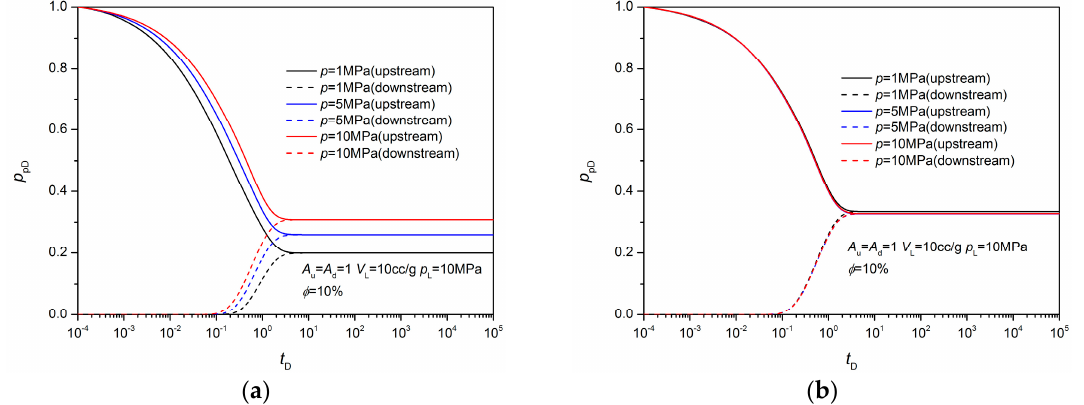
Figure 2. The influence of the testing pressure on the pseudo-pressure curves of the equilibrium sorption model. ( a ) Old dimensionless definition. ( b ) New dimensionless definition.